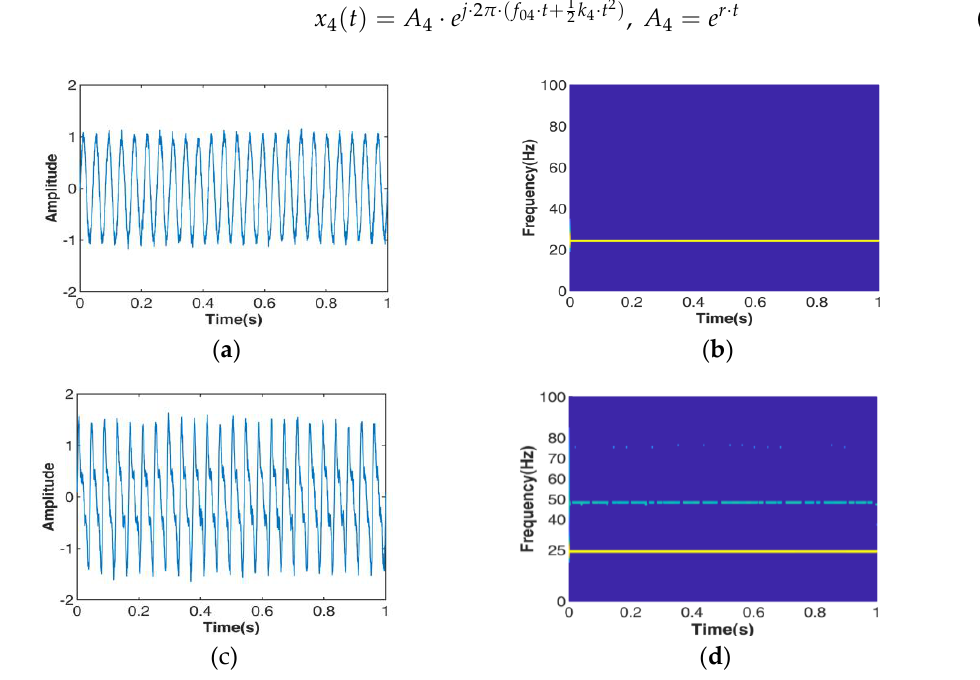
Figure 8. Comparison of rotor in both normal and misalignment vibration states. ( a ) Time domain representation of rotor in normal state; ( b ) SEST time-frequency representation of rotor in normal state; ( c ) time domain representation of rotor misalignment vibration; ( d ) SEST time-frequency representation of rotor misalignment vibration.